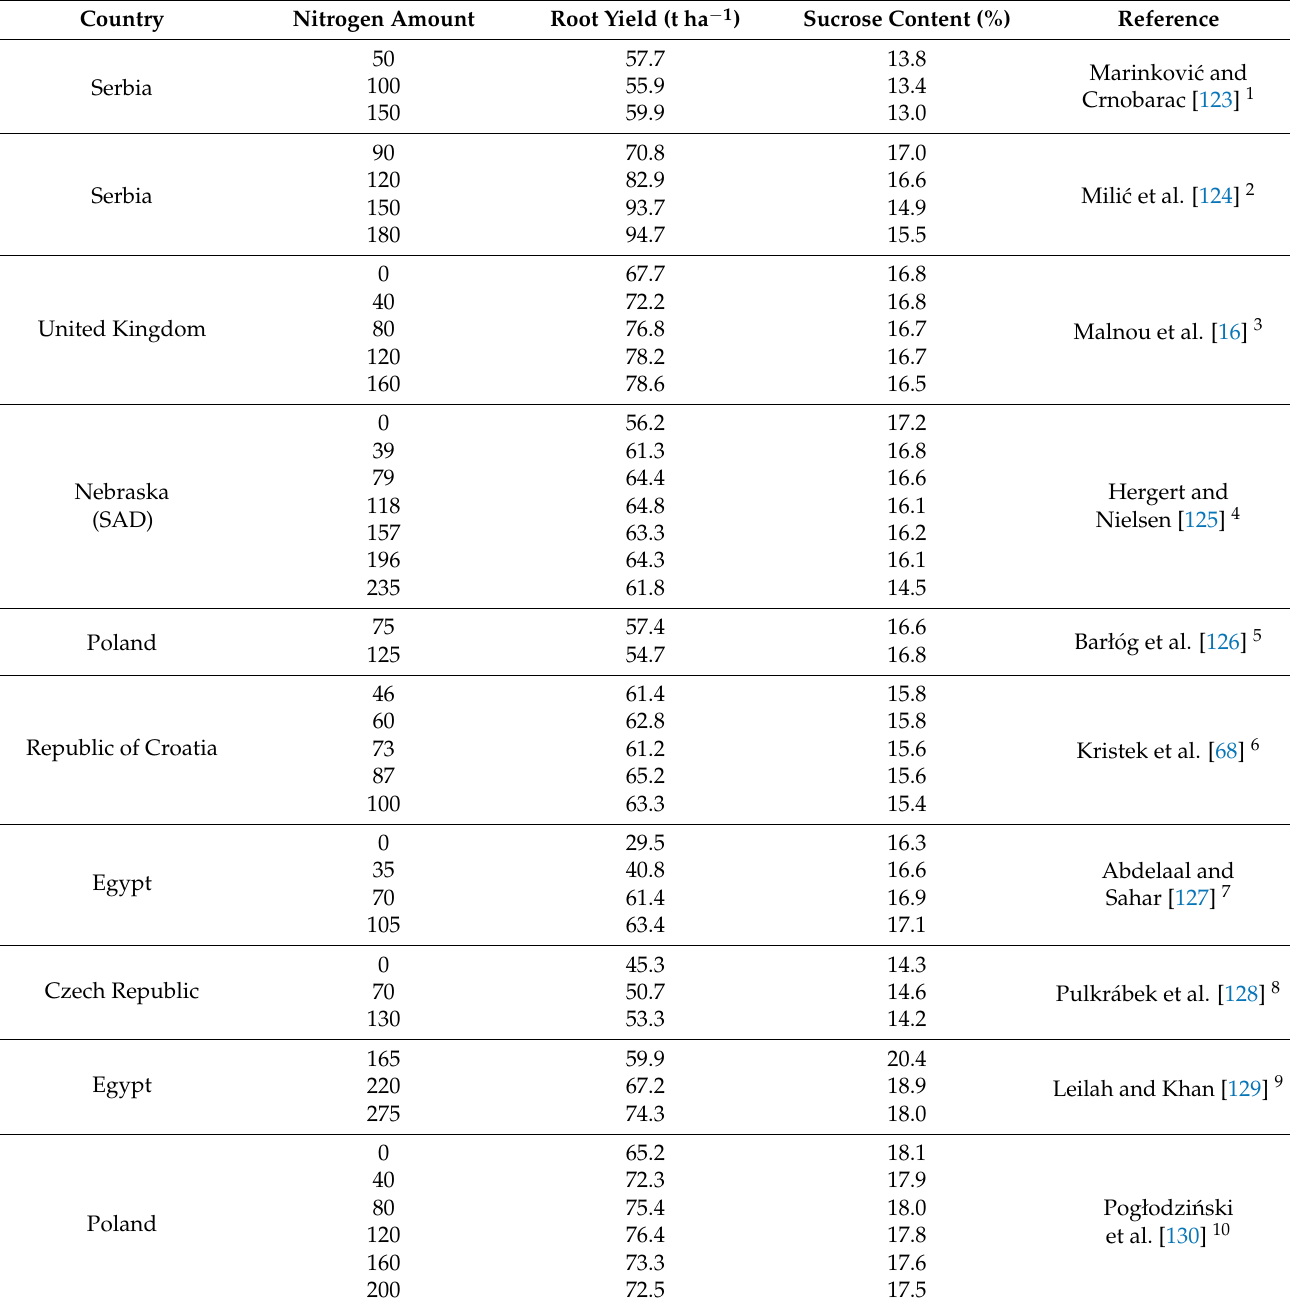
Table 1. Different amounts of N and their influence on final sugar beet